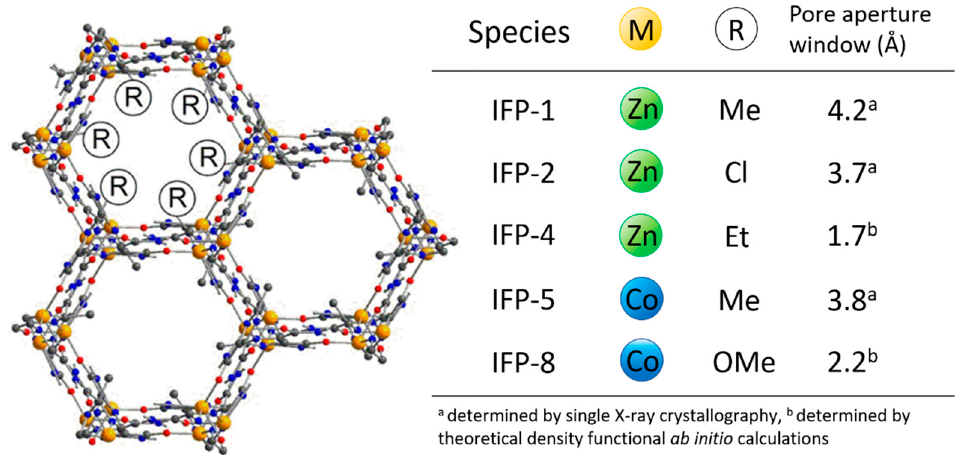
center, M, and the substituent R, at the C2 position of the amide-imidate-imidazolate (C 5 H 3 N 4 O 2 ) linker (for IFP-1: M = Zn, R = CH 3 ; IFP-2: M = Zn, R = Cl; IFP-4: M = Zn, R = C 2 H 5 ; IFP-5: M = Co, R = CH 3 ; IFP-8: M = Co, R = OCH 3 , [39–41], see Figure 2).